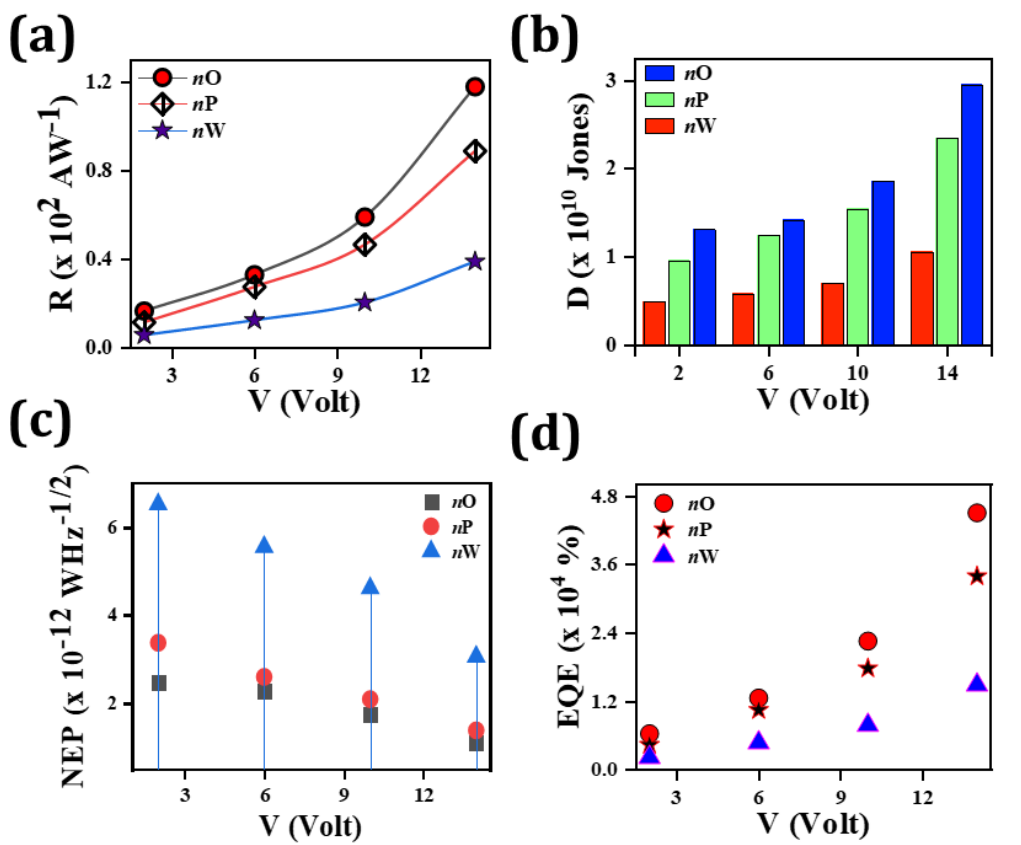
Figure 7. A comparative bias-dependent performance parameter: ( a ) R, ( b ) D, ( c ) NEP, ( d ) EQE at fixed 225 µW optical power. Table 2. A comparison of the performance metrics for fabricated GaN/AlN/Si heterostructure-based